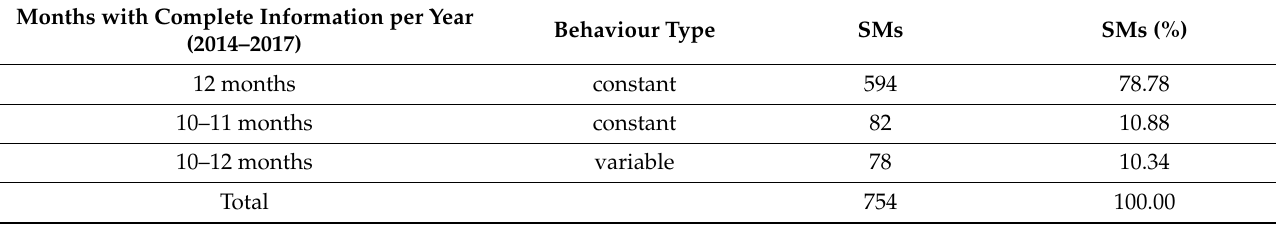
Table 2. Result of the analysis of the space-time cubes. First column indicates the number of months with complete measurements per year. Behaviour type indicates if the SM stayed constant in its behaviour categorisation (membership of the